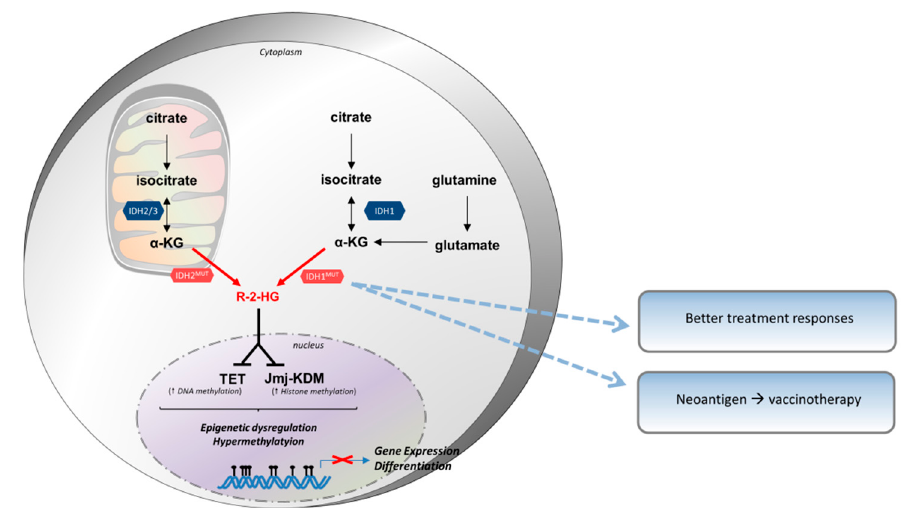
Figure 4. Isocitrate dehydrogenase (IDH) mutations in cancer cells and their clinical impact. Wild-type IDH1 (cytosol) and IDH2/3 (mitochondria) catabolize the oxidative decarboxylation of isocitrate into α -ketoglutarate ( α -KG). This reaction generates CO 2 and replenishes NADPH pools in the cell. IDH mutants (IDH MUT ) display a reduced affinity for their natural substrate, while gaining neomorphic activity to convert α -KG into R-2-hydroxyglutarate (R-2-HG). R-2-HG is an oncometabolite that